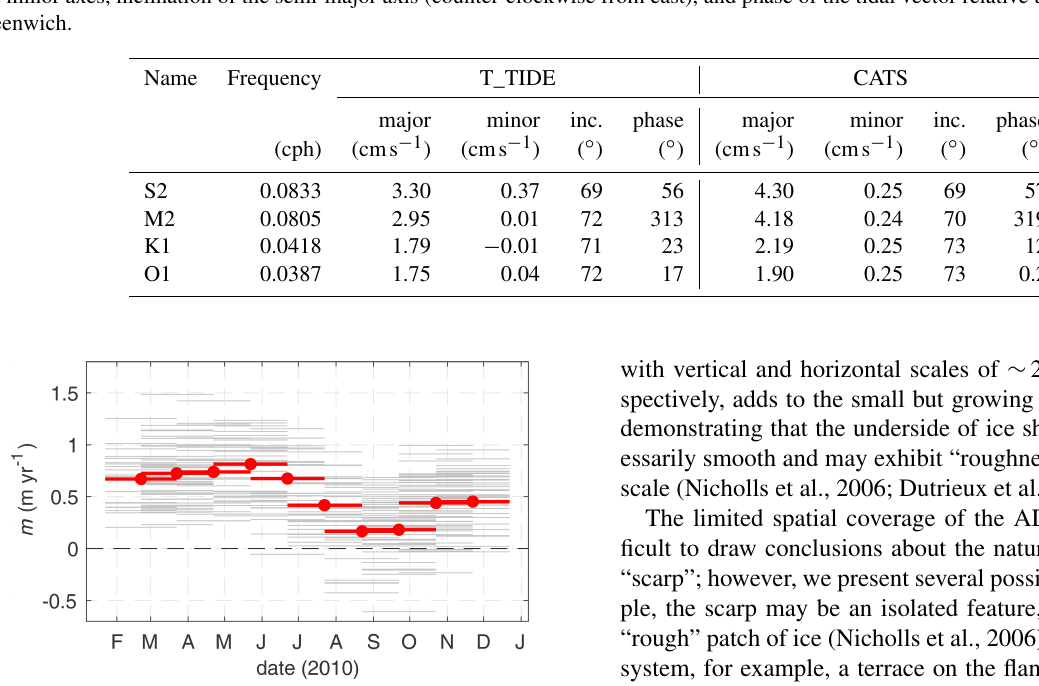
Figure 8. Observed melt rates from the ADCP at monthly resolution for (grey) each bin (d φ, d r ) and (red) the area average, where the area is outlined in Fig. 7. Melt rates are calculated from interface depth using centred differences (i.e. m t = (h t + 1 − h t − 1 )/( 2 (cid:49)t))